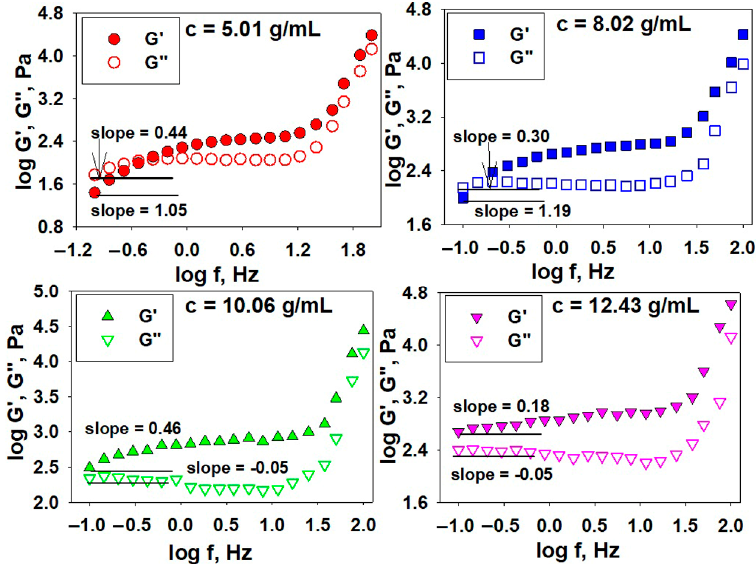
Figure 9. Log–log plots of storage (G ′ ) and loss moduli (G ″ ) versus frequency (f) for PSFEtP + solutions at different concentrations.